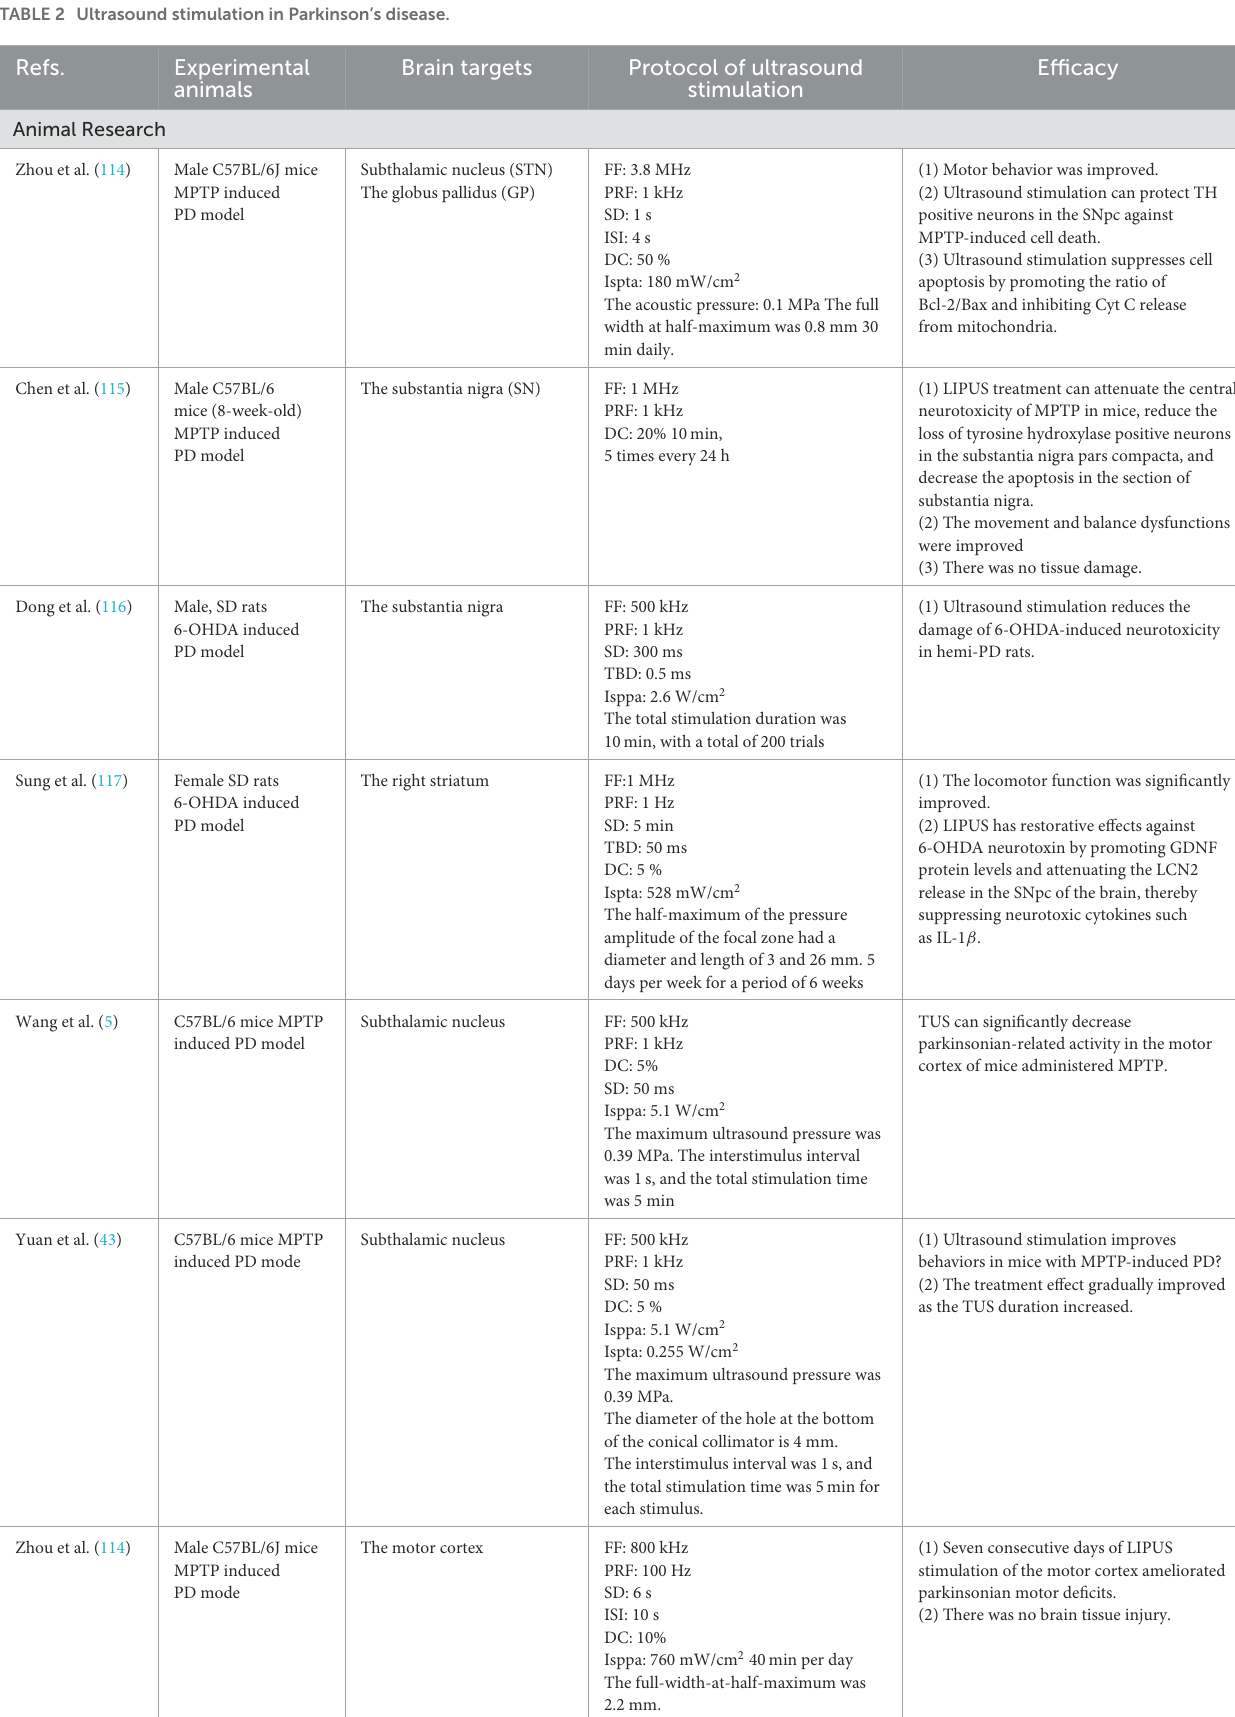
TABLE 2 Ultrasound stimulation in Parkinson’s disease.